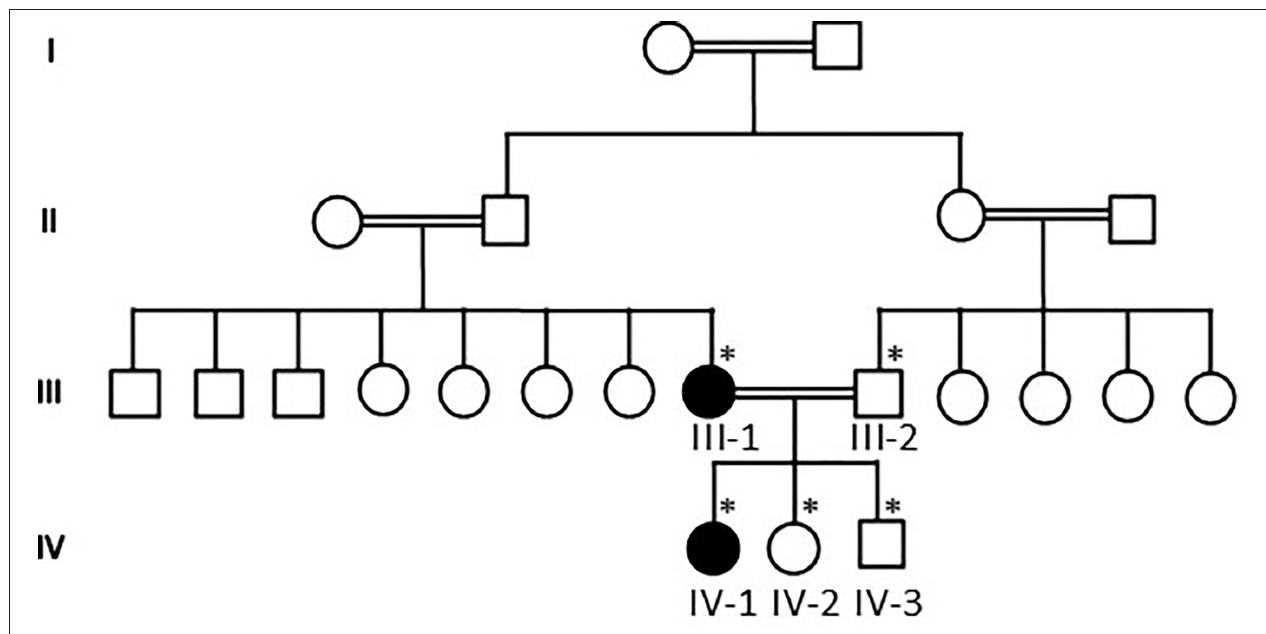
FIGURE 1 | Pedigree of the family showing that consanguineous marriages and III-1 mother and IV-1 are the affected members of the family. The * sign represents the samples available for the